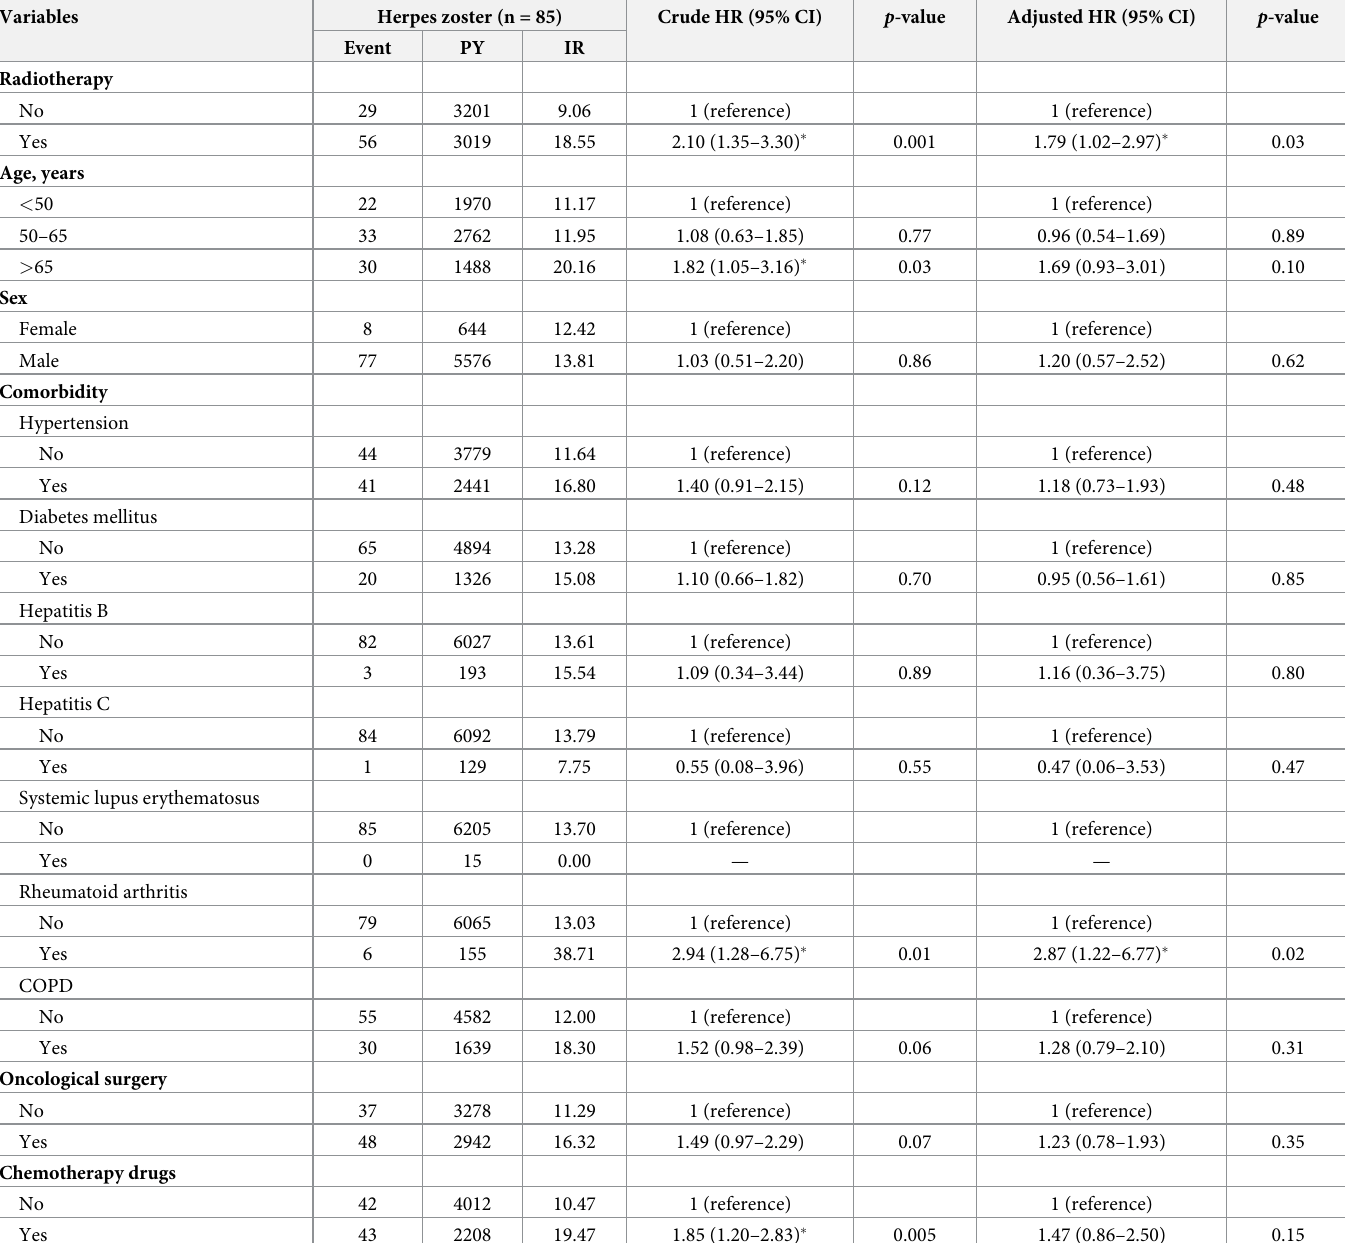
Table 2. Univariate and multivariate analyses of confounding factors associated with herpes zoster. Variables